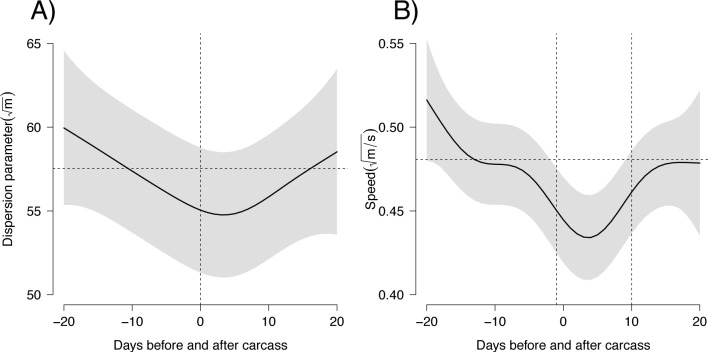
Scattering parameter (A) and movement metrics (B) immediately before and after a carcass was available.The horizontal dotted line represents the mean predicted value during the 20 days prior to when a carcass was available. The grey shaded areas represent confidence intervals. The vertical dotted lines indicate the time during which speed (12 days) is consistently below the average value recorded for the 20-days period prior to carcass availability.